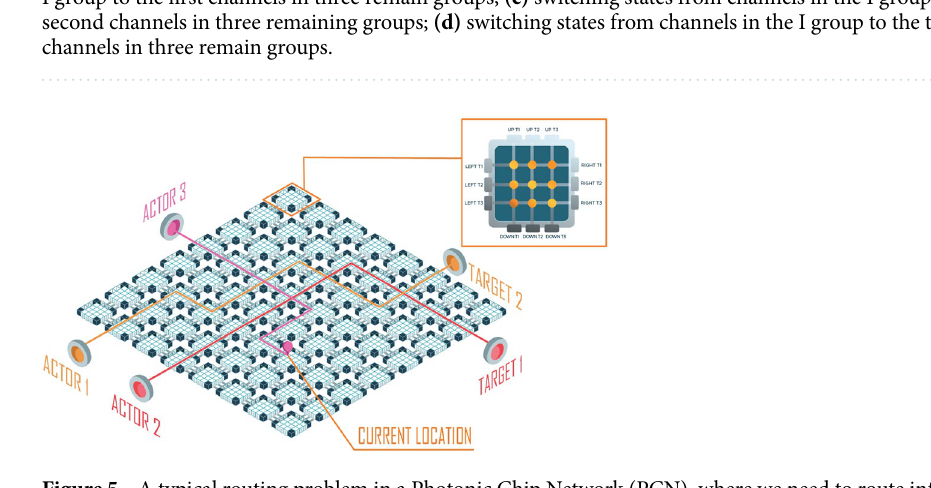
Figure 5. A typical routing problem in a Photonic Chip Network (PCN), where we need to route information between multiple input-output pairs